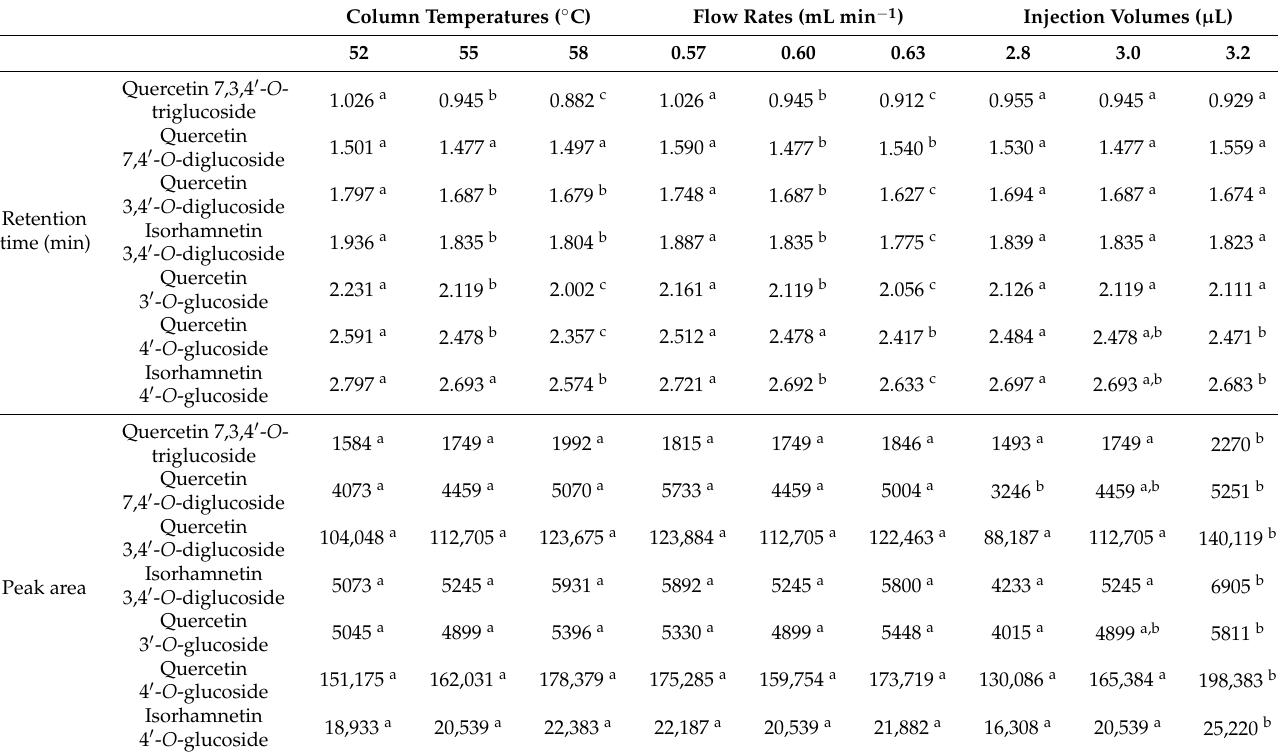
Table 4. Robustness of the UHPLC method